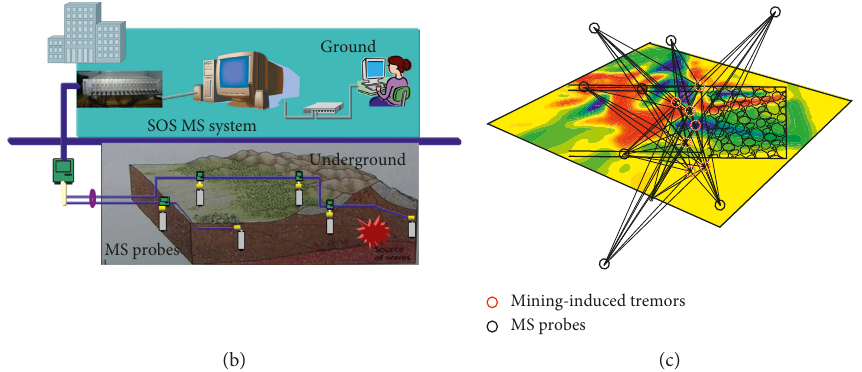
Figure 3: Layout of seismic geophones (a) and schematic maps of SOS MS system (b) and seismic velocity tomography (c).